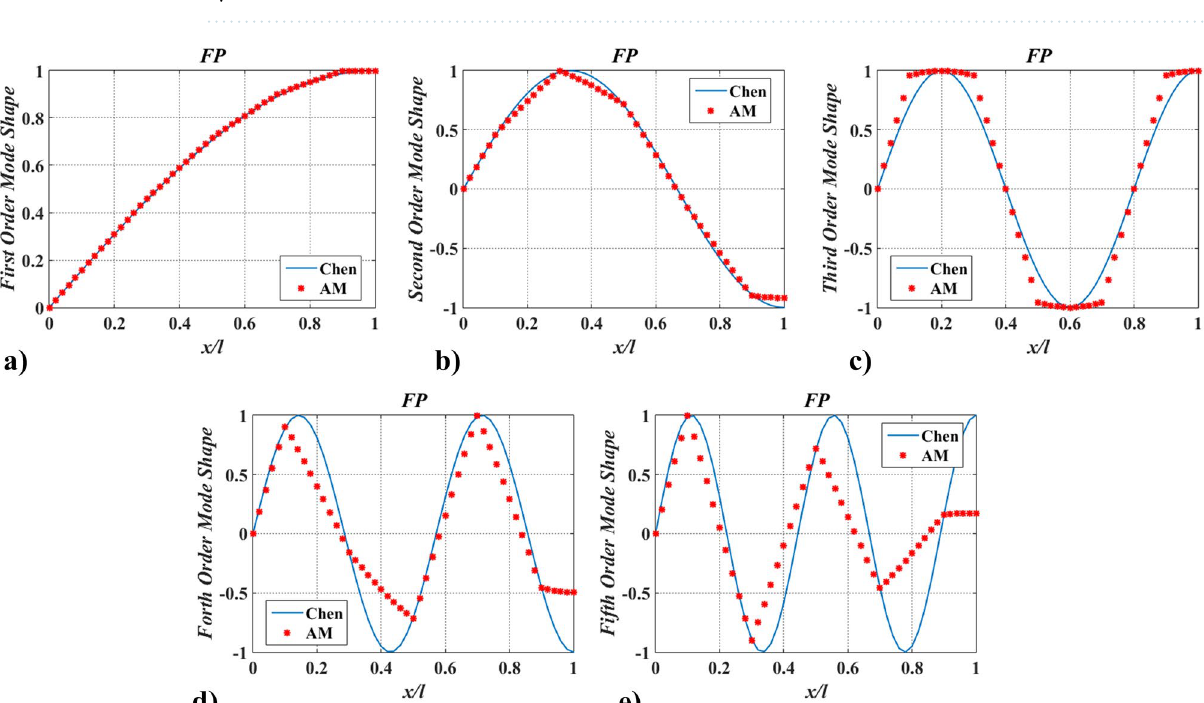
Figure 7. The lowest five mode shapes of twisting angles for the shaft carrying five concentrated elements in the FP support conditions obtained from Chen 20 and